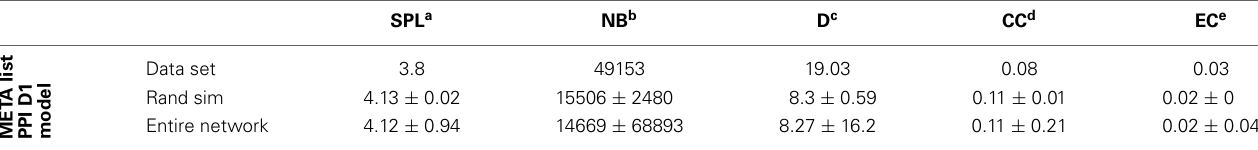
Table 4 | Topological analysis of the META list, PPI D1 model, using TopoGSA.